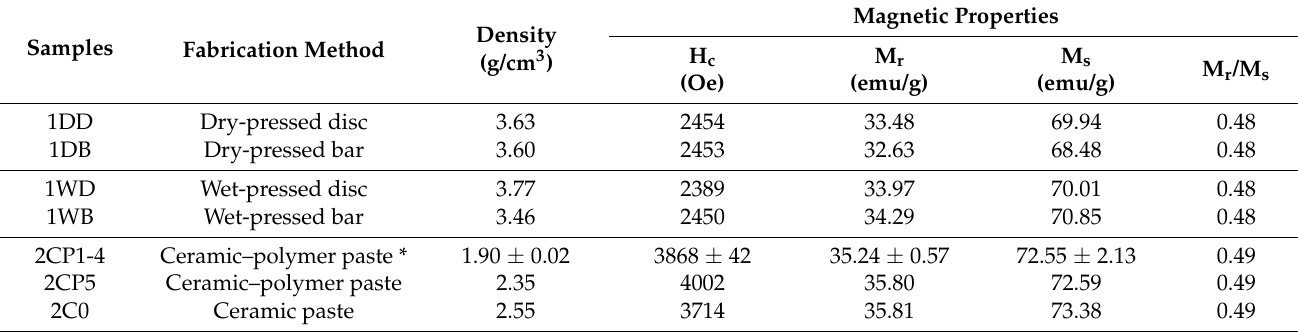
Table 1. Density and magnetic properties of the BaFe 12 O 19 magnets from powder compaction and paste-injection